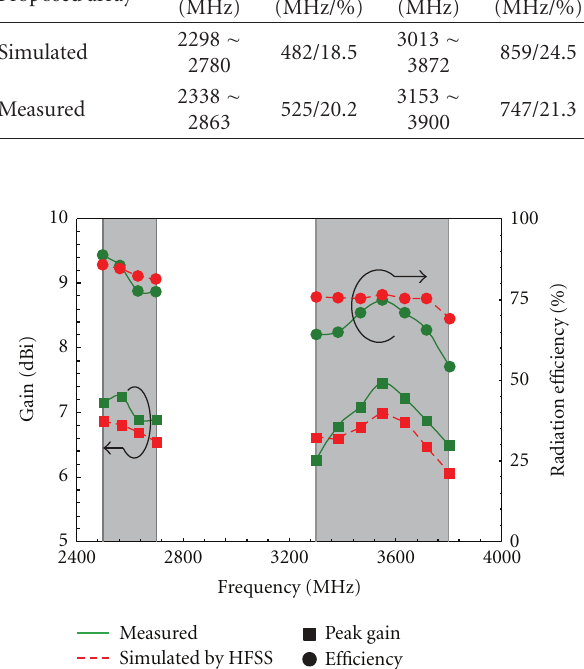
Figure 3: Simulated and measured peak gains and e ffi ciencies across the operating bands for the proposed dual-band dipole